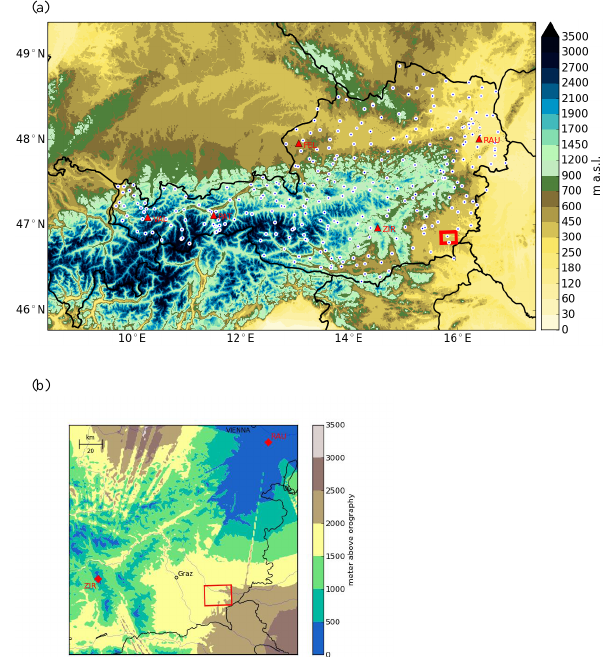
Figure 2. (a) Operational rapid-INCA domain, orography and rain gauge stations (TAWES) measuring precipitation in 5min in- tervals (white/blue dots). Additionally, the locations of the five radars are marked (red triangles) as well as the WegenerNet re- gion (red square). (b) Relative height of the lowest available radar beam above orography, in combination with the location of the WegenerNet (red box) and the locations of the radars Rauchenwarth (RAU) and Zirbitzkogel (ZIR) (red